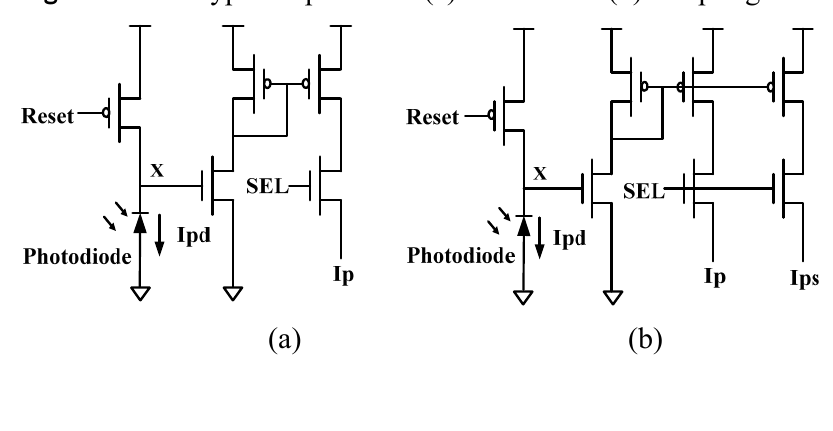
Figure 5. Two types of pixel cell (a) normal cell (b) sampling